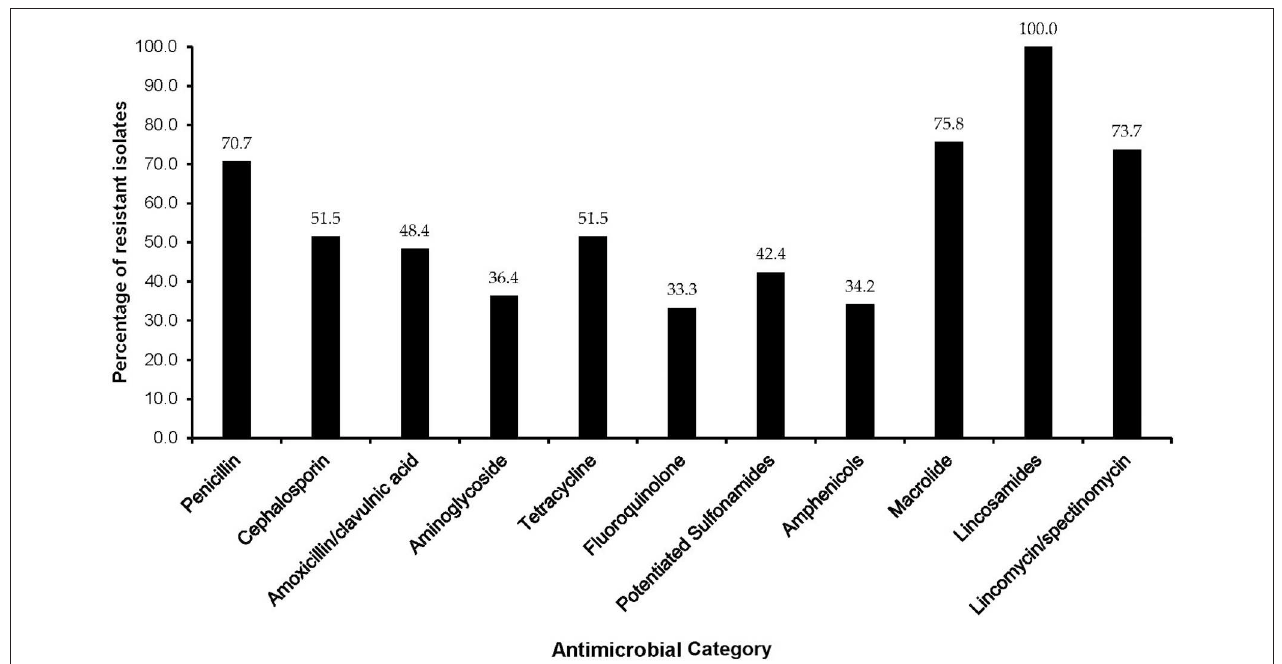
FIGURE 4 | Distribution of multidrug resistant isolates by antimicrobial category among dogs presented at a referral veterinary teaching hospital in South Africa, 2007-2013.